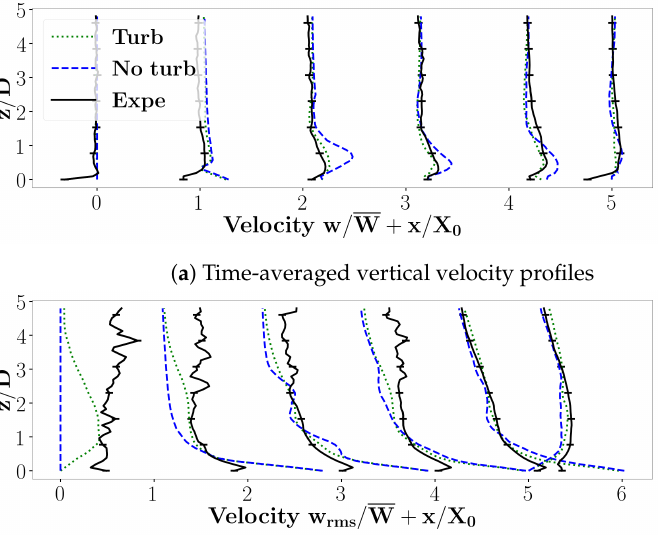
Figure 13. Comparison of wall-normal velocity and associated RMS values for lab-scale numerical results with and without inlet turbulence with experimental data on jet axis at the locations × provided in Figure